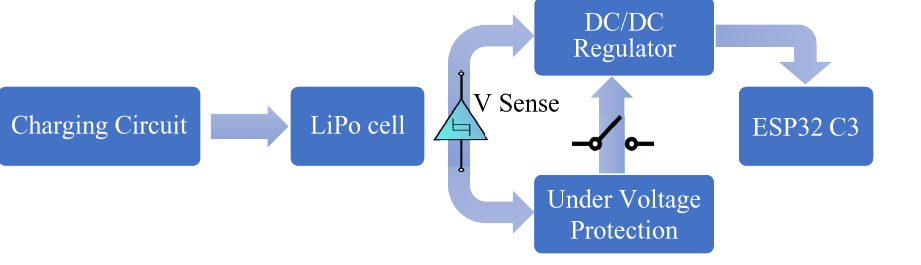
Figure 4. The BLE tag hardware circuit overview. Table 1. BLE contact tracing system hardware components and their prices.